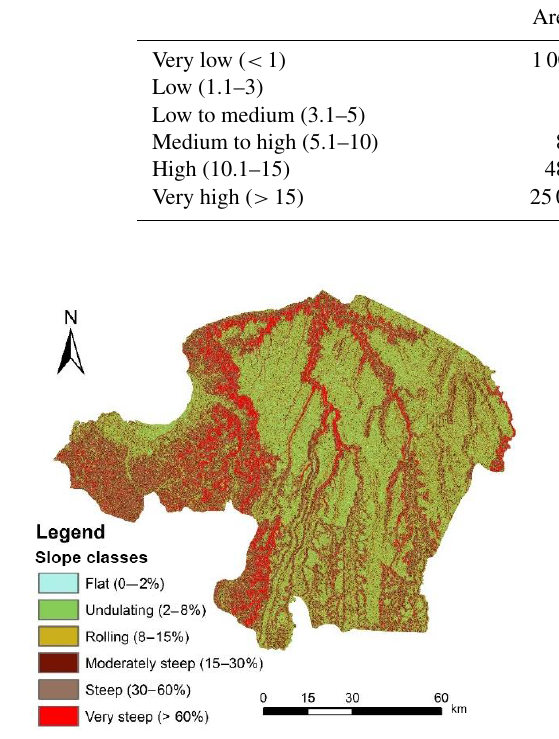
Figure 2. Slope classes of the study